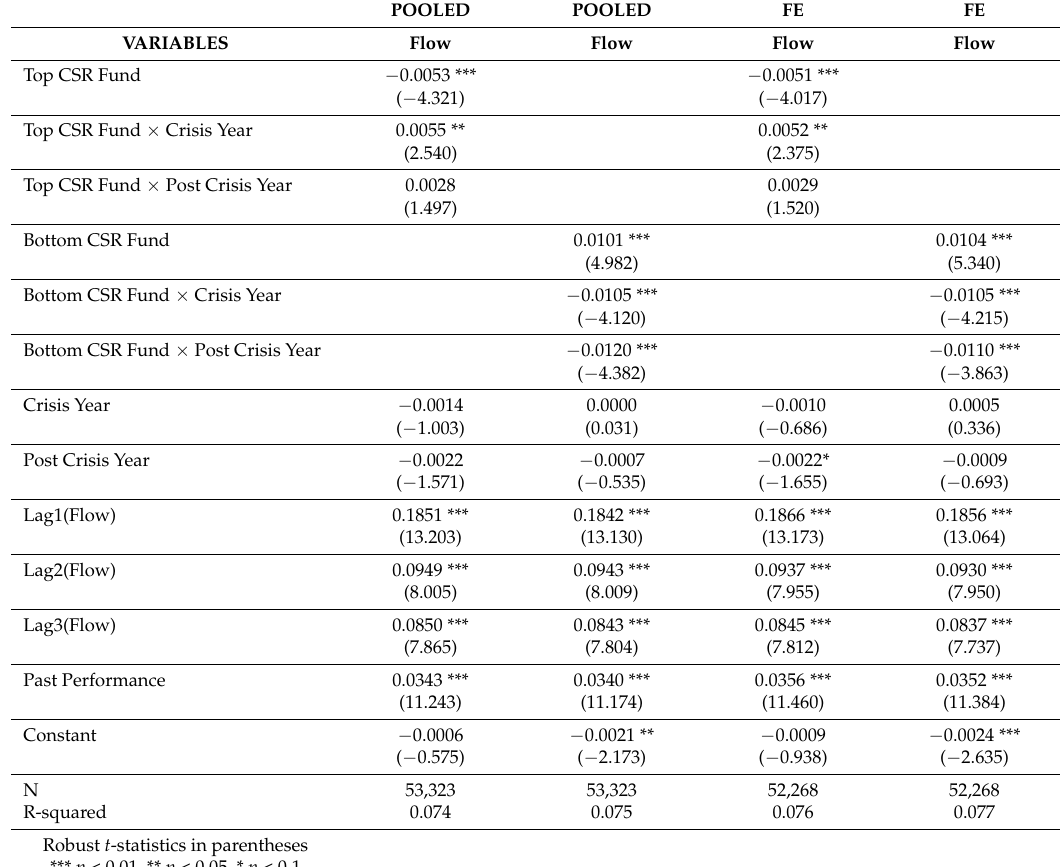
Table 9. CSR fund flows, financial crisis and post-crisis period (alternative CSR